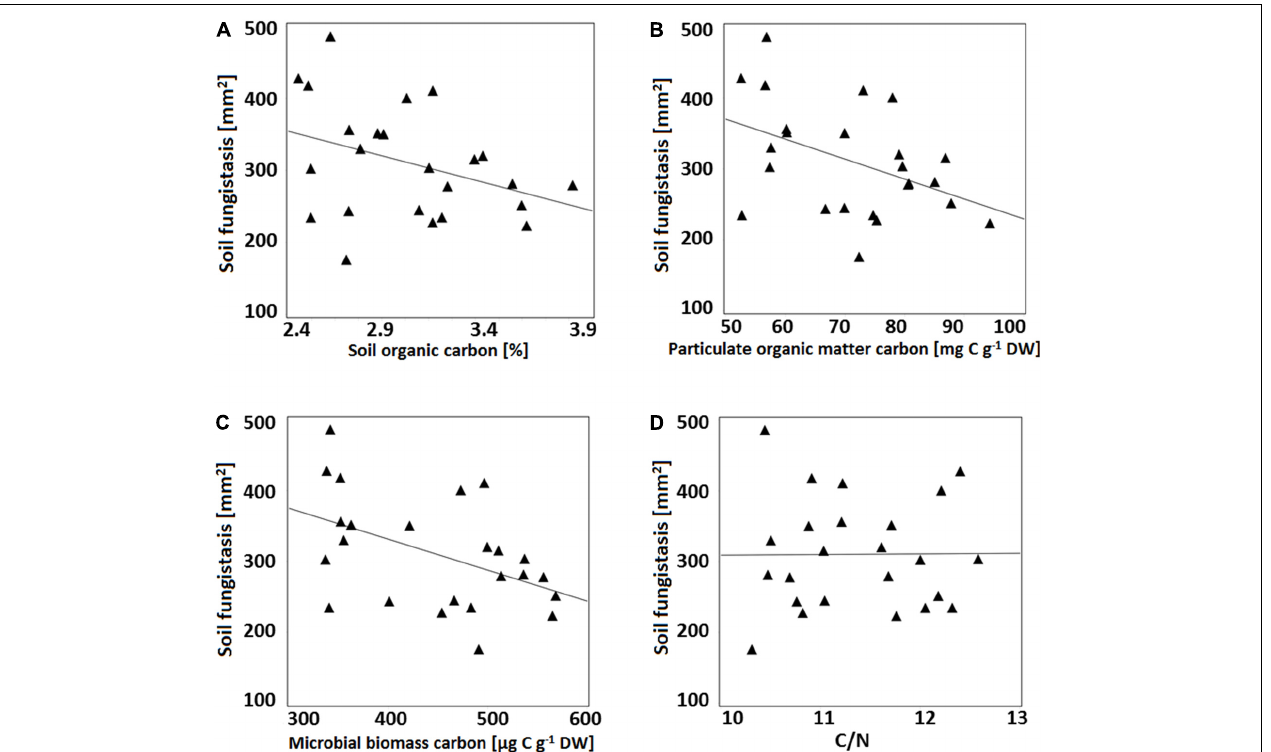
FIGURE 1 | Correlation between fungistasis activity in soil ( y -axis; mm 2 at the surface bioassay; the smaller growth area of the test fungus F. culmorum , the stronger the soil fungistasis) and different top soil (0–5 cm) organic carbon fractions. (A) Soil organic carbon (SOC), %; r = –0.34, p = 0.10); (B) Particulate organic matter carbon (POM-C), mg C g − 1 ; r = –0.40, p = 0.05); (C) Microbial biomass carbon (Cmic), µ g Cmic g − 1 ; r = –0.40, p = 0.06), and (D) C/N (Soil total carbon to nitrogen ratio; r = 0.05, p =